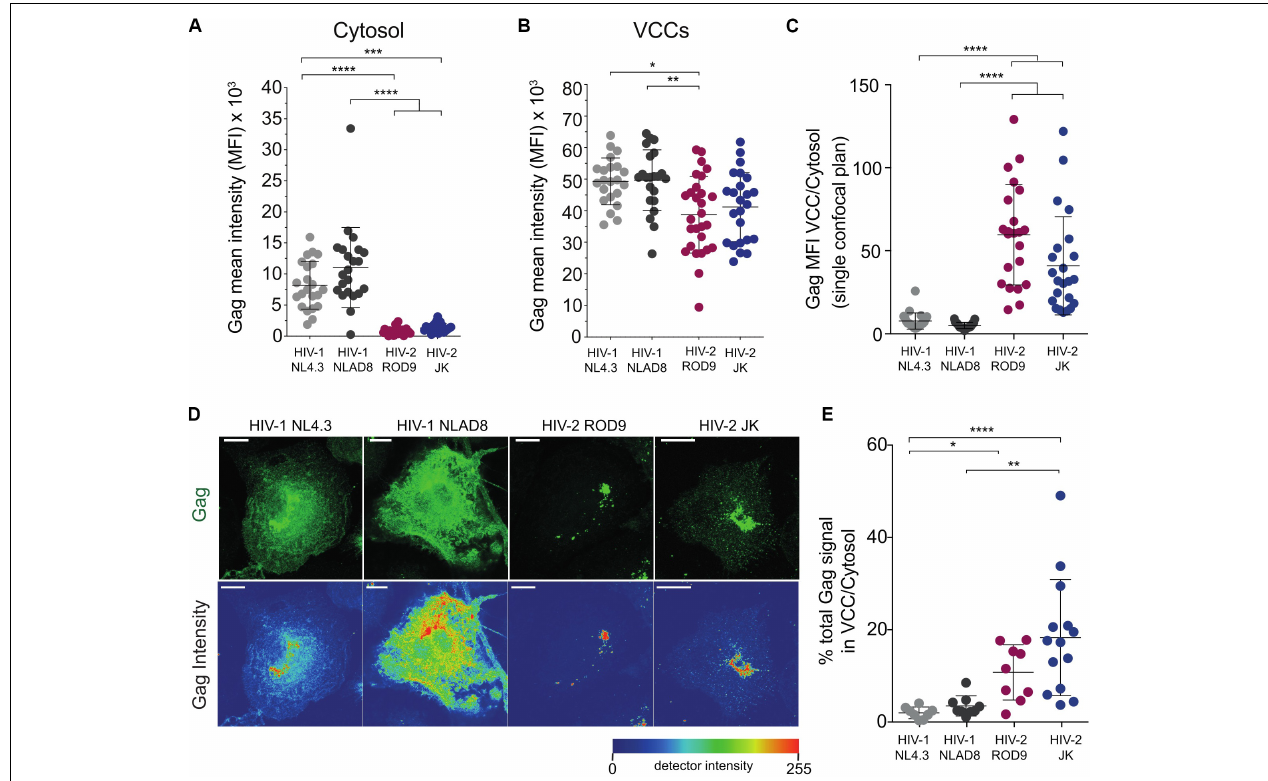
FIGURE 3 | Gag is concentrated in the viral-containing compartment of HIV-2-infected MDMs. (A,B) Gag MFI in the cytosol (A) and in the VCCs (B) . A macro was used to build masks that delimited the VCCs based on Gag and the Cytosol based on CD44 plasma membrane staining (see section “Materials and Methods”). (C) Gag enrichment in the VCCs calculated as the ratio of the MFI in VCCs (B) over the MFI in the cytosol (A) on confocal sections. (D) Representative Z projections of a stack of images obtained by confocal microscopy. Images displayed on the second row represent intensity maps for Gag expression using pseudo-color. Bar = 10 µ m. (E) Z stacks of infected MDMs were used to obtain 3D masks and to determine the % of Gag signal present in VCCs over Gag signal present in the rest of the cells. Each dot represents a cell. Data presented from a representative donor from at least 6. P -values were calculated using Kruskal–Wallis non-parametric test with Dunn’s correction for multiple comparisons. P -values lower than 0.05 were considered as significant (* p < 0.05, ** p < 0.01, *** p < 0.001, **** p <